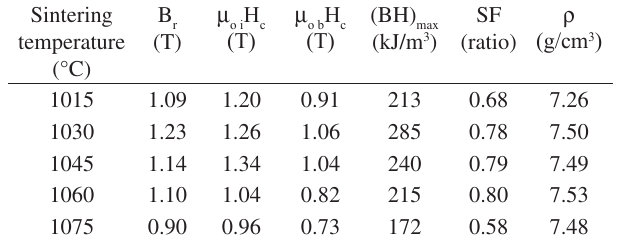
Fe B HD magnets pre- 17 79 4